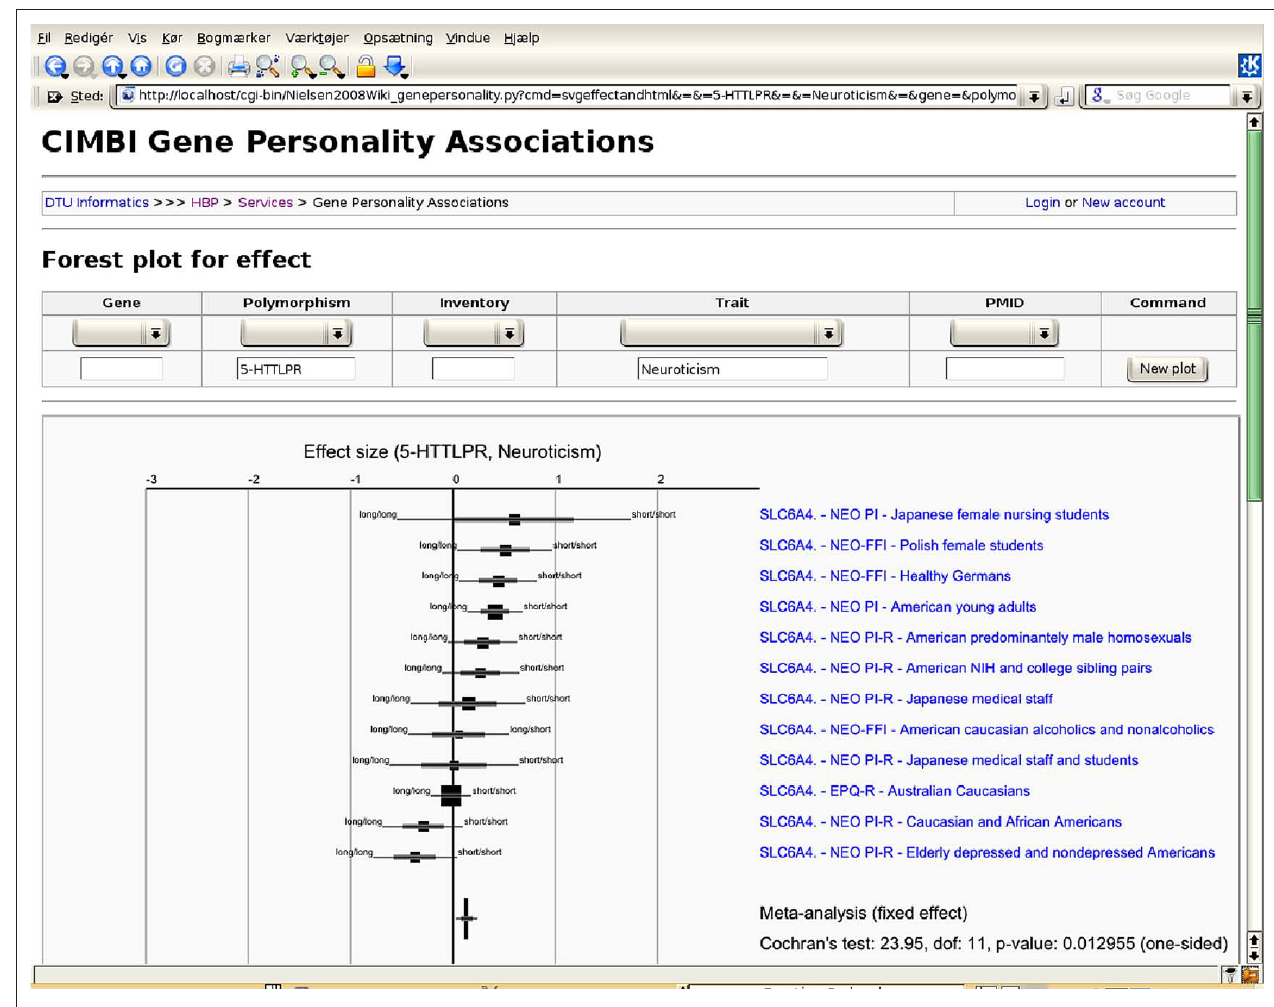
FIGURE 1 | Meta-analytic forest plot as a Web service with studies on personality genetics. Components in the Scalable Vector Graphics image fi le are hyperlinked and the content may be controlled interactively through a HTML